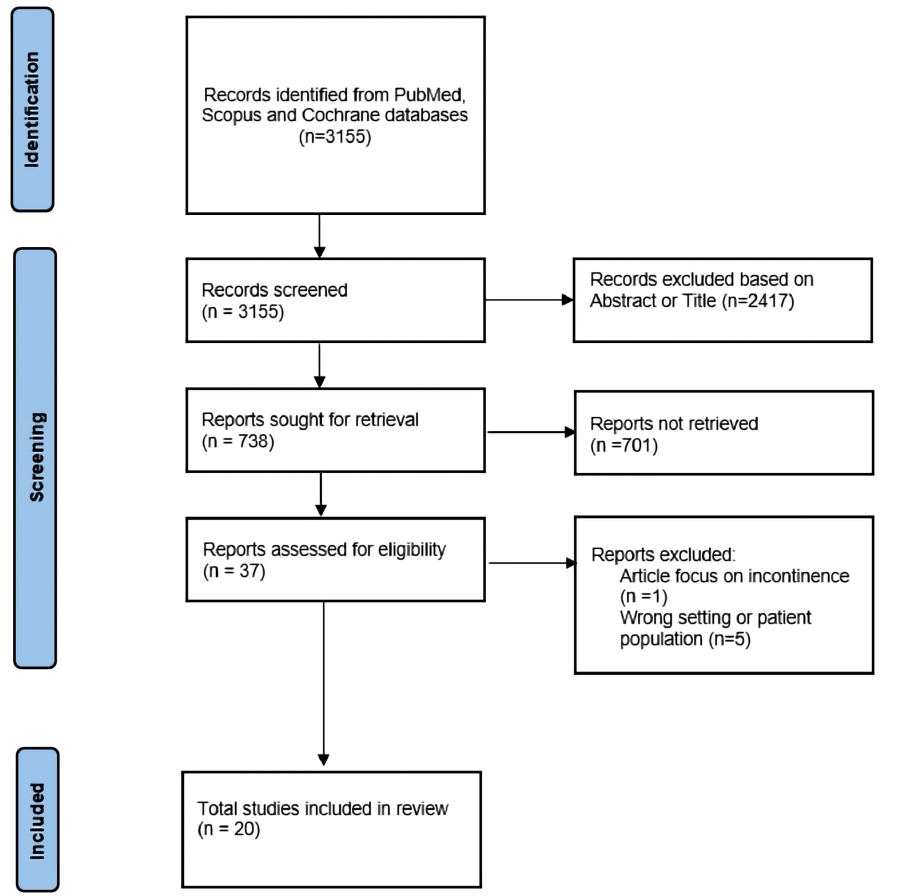
Figure 1. The flowchart of the search strategy for this